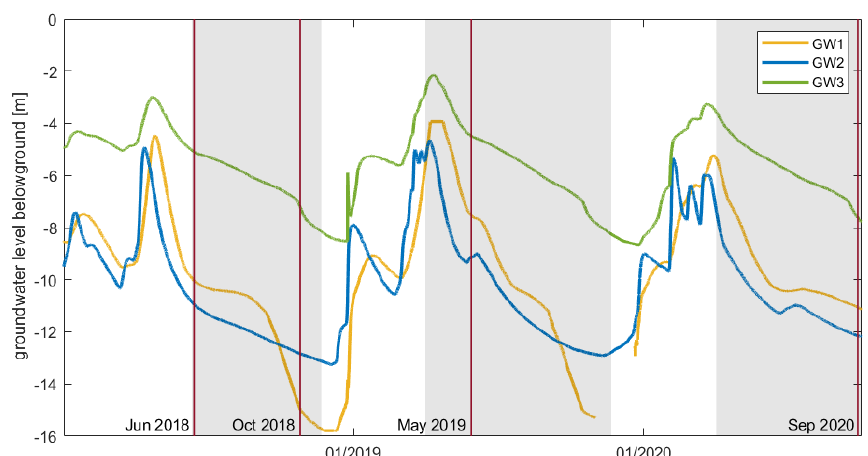
Figure 2. Groundwater (GW) levels at GW1, GW2 and GW3 from 2018 to 2020. The shaded areas represent the three sampling periods and the red lines the selected